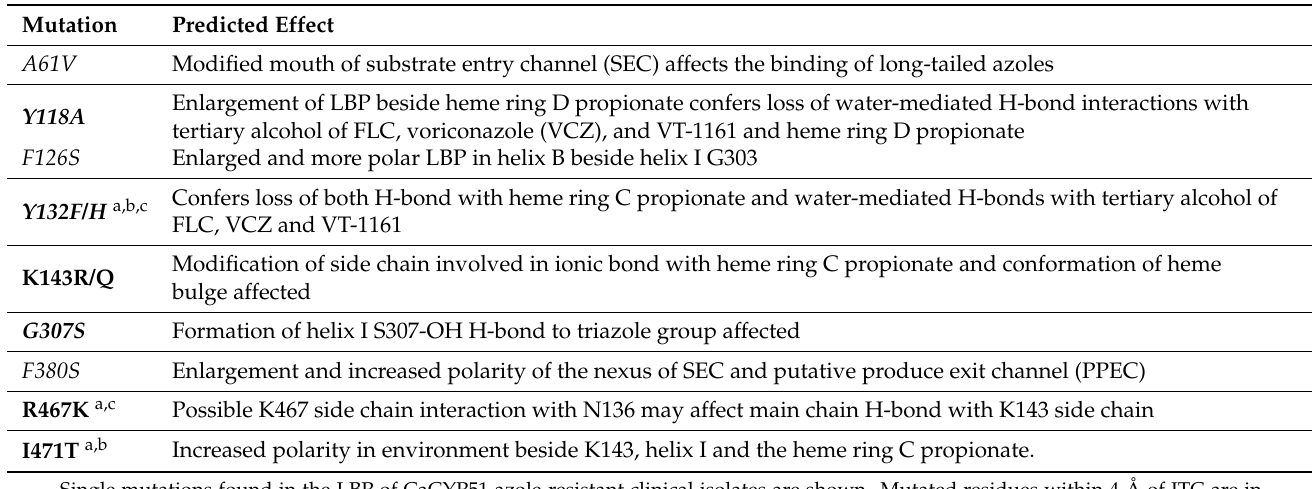
Table 2. Single amino acid substitutions in C. albicans CYP51 LBP that confer azole